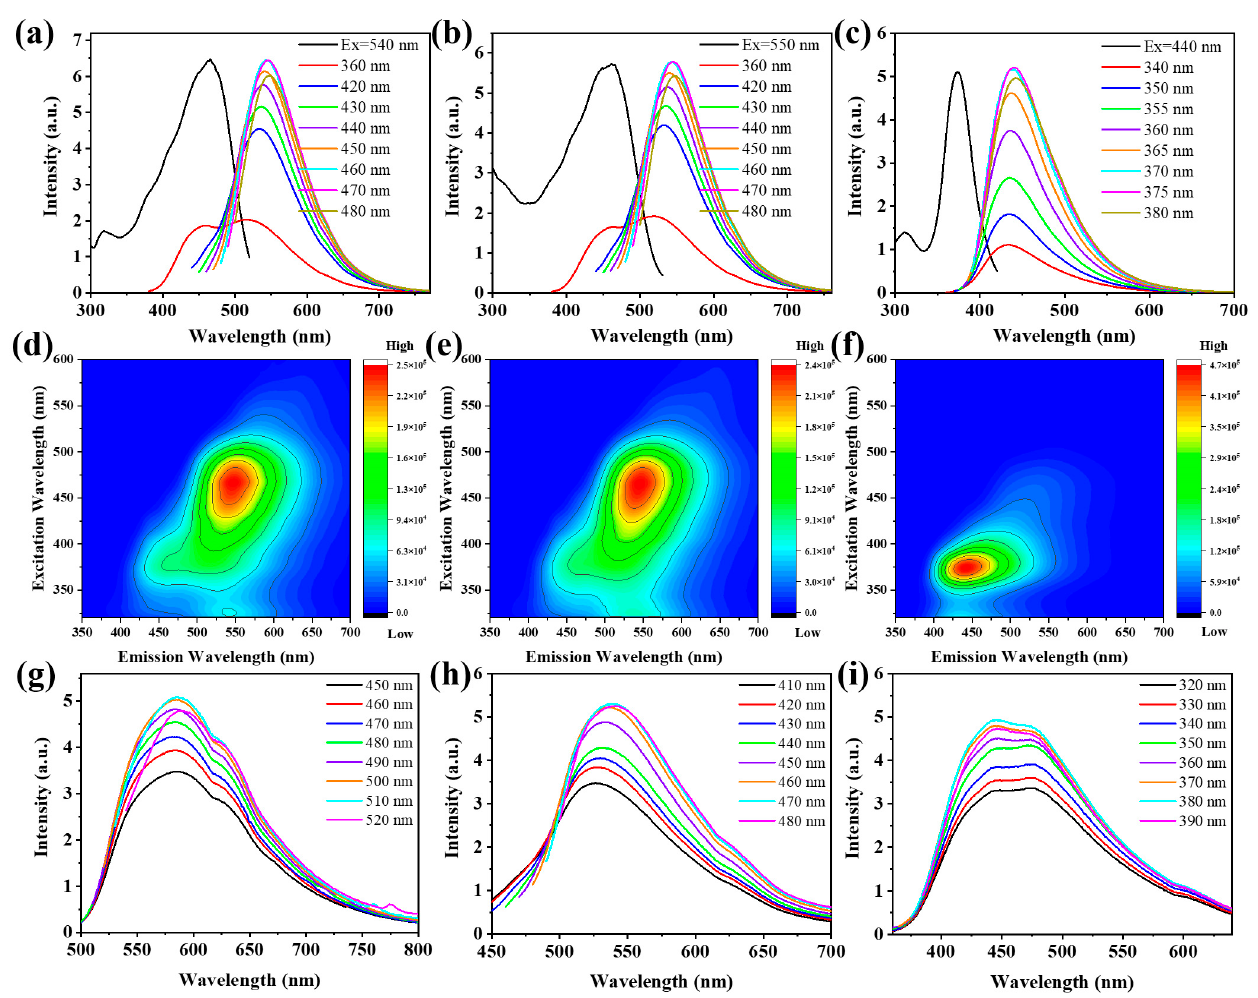
Figure 4. ( a – c ) Excitation, emission and ( d – f ) 3D spectra of O-CDs, G-CDs and B-CDs in ethanol solution ( c = 0.1 mg/mL). ( g – i ) PL spectra of O-CDs, G-CDs and B-CDs in the solid state. Table 1. Fluorescence characterization data of O-CDs, G-CDs and